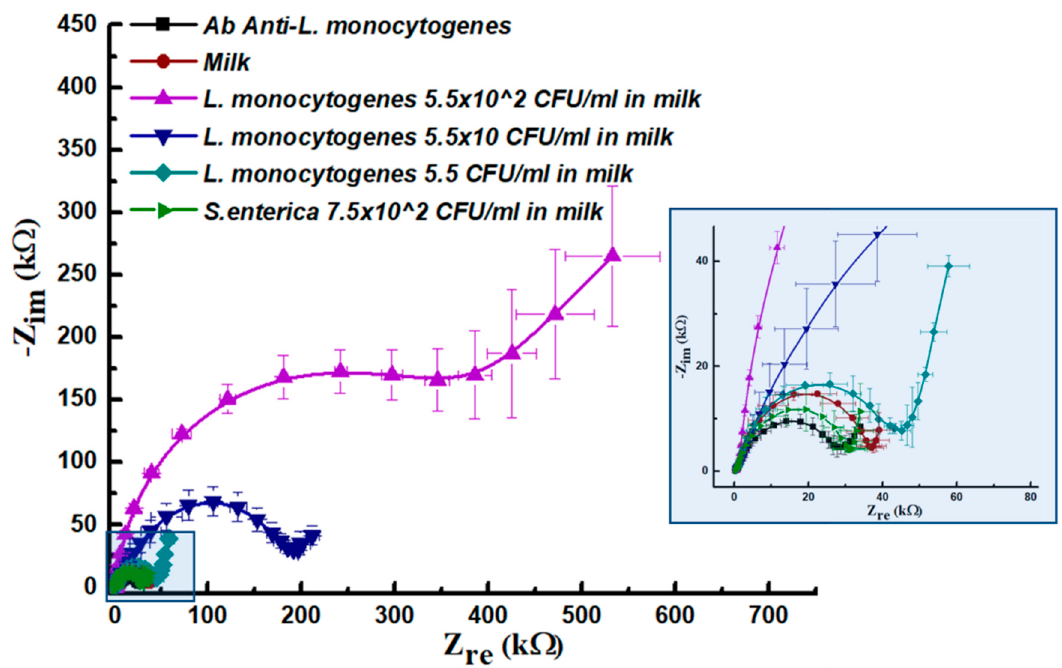
Figure 4. Nyquist spectra collected for milk spiked samples in presence of different concentrations of L. monocytogenes . Negative controls included milk matrix and S. enterica in milk .